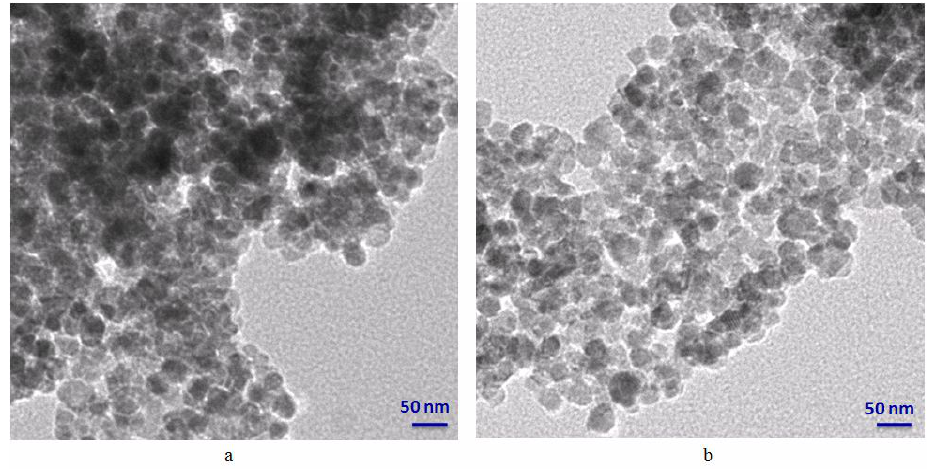
Fig. 4. TEM images of (a) TiO